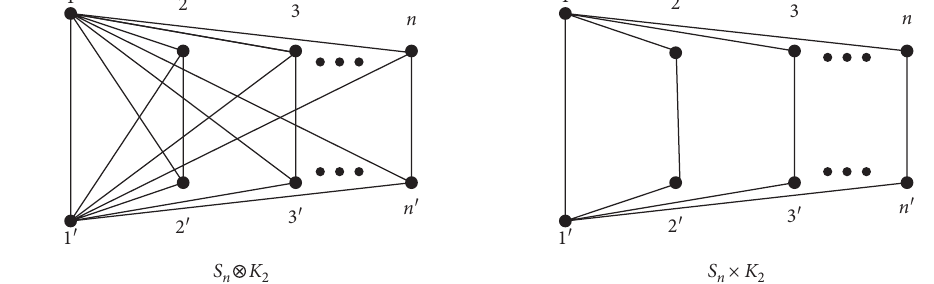
Figure 1: The graphs S